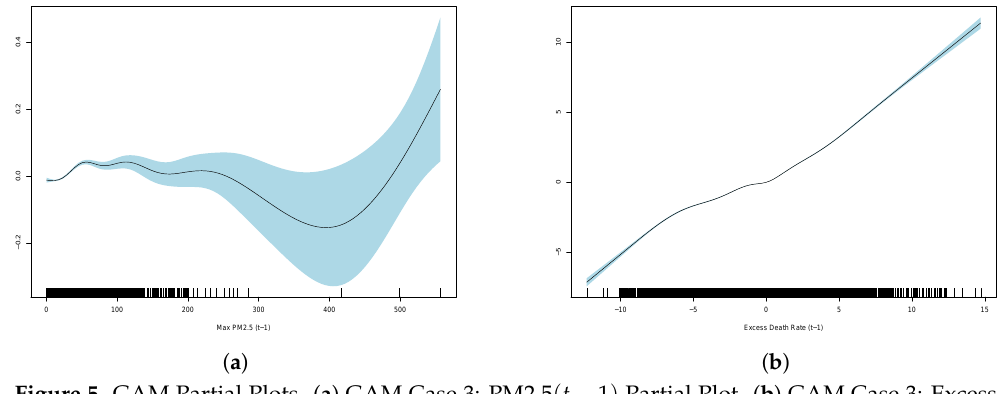
Figure 5. GAM Partial Plots. ( a ) GAM Case 3: PM2.5 ( t − 1 ) Partial Plot. ( b ) GAM Case 3: Excess Death ( t − 1 ) Partial